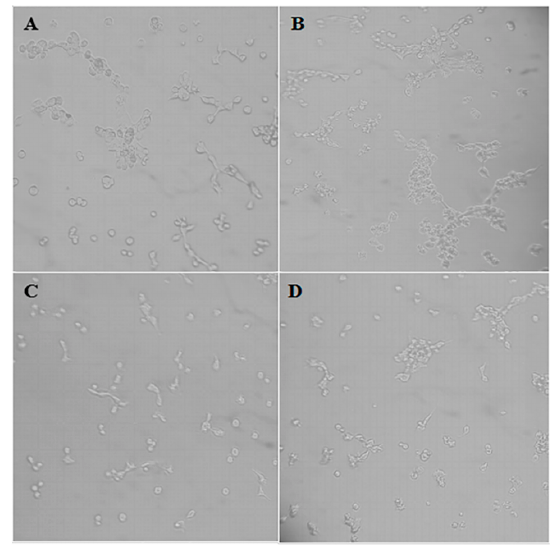
Figure 17. The migratory capacity of human umbilical vein endothelial cells (HUVECs). ( A ) Nontreated HUVECs, ( B ) VEGF-rich medium treated HUVECs, ( C ) GRcR/ VEGF-siRNA treated HUVECs, and ( D ) Lipo™2000/ VEGF-siRNA treated HUVECs. (Original magnification: 5 × ).